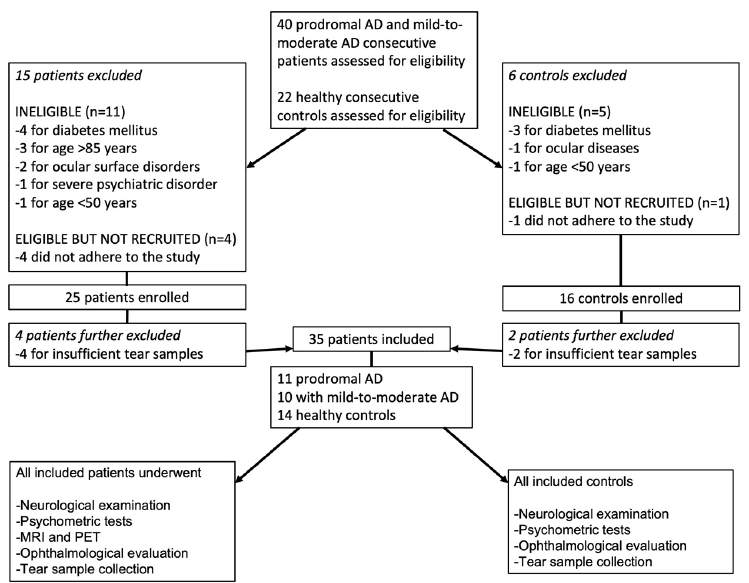
Figure 1. Flowchart of patients’ enrollment assessment according to the inclusion and exclusion criteria and their further exclusion as indicated in the Materials and Methods section. AD: Alzheimer’s disease, OCT: Optical coherence tomography.